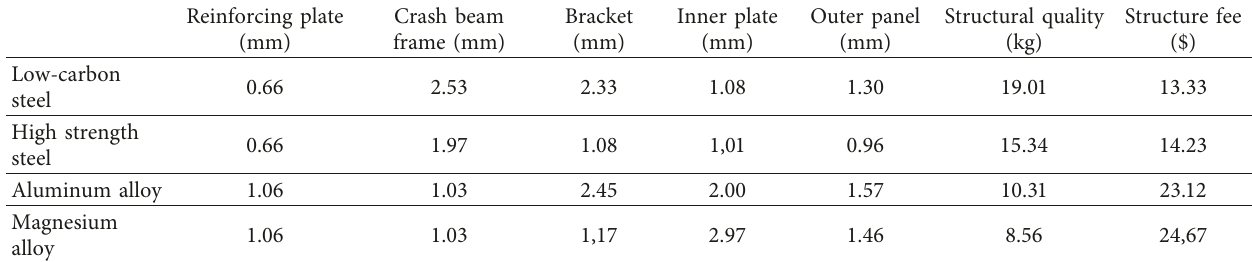
Table 2: Results of structural optimization parameters.